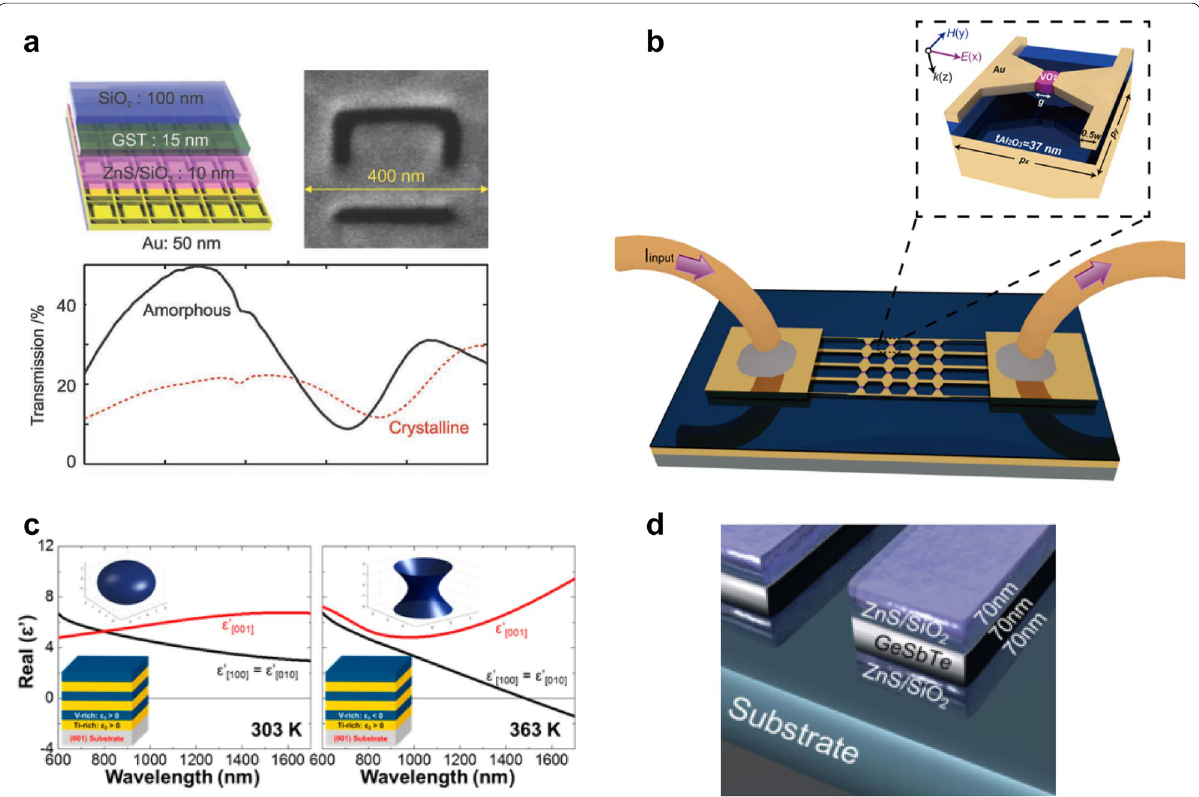
Fig. 5 Phase‑change‑material‑based tunable metasurfaces. a Optically tunable thermal metamaterial based on GST [73]. Reproduced with permission from ©2013, WILEY–VCH. b Meta‑atom made of a bow‑tie‑shaped unit cell that has a small amount of the VO2 [74]. Reproduced with permission from ©2017, American Chemical Society. c Metal‑dielectric heterostructure for hyperbolic dispersion under thermal modulation